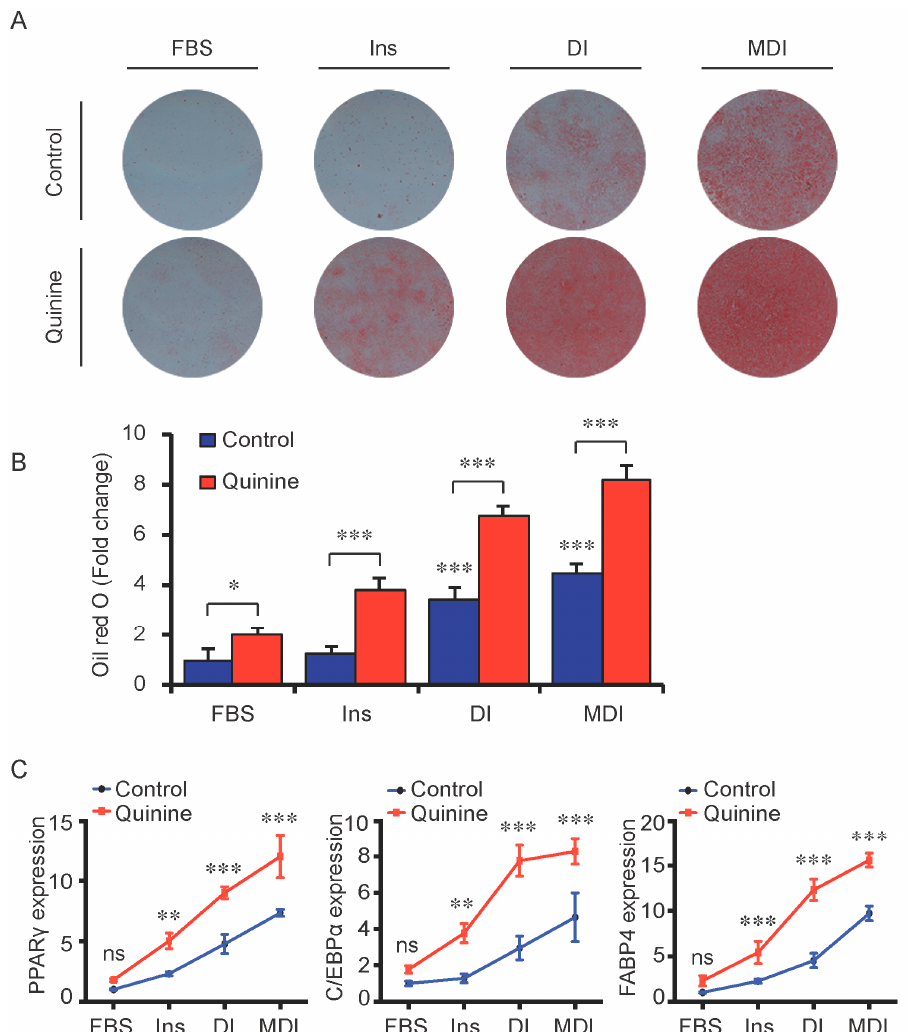
Figure 2. Quinine induced adipogenesis was independent of induction conditions. The effects of quinine on differentiation of mouse primary preadipocytes were assessed using Oil Red O stain and qRT-PCR on Day 14 of differentiation with different induction conditions (FBS alone, FBS + Insulin, FBS + DI and FBS + MDI) in the presence of 20 µM quinine. FBS alone was used as control. Ins represents Insulin. ( A ) Oil Red O stain showed lipid accumulation (pictures shown here represent three independent experiments). The plates were scanned after Oil Red O stain; ( B ) Quantification of Oil Red O stain from three independent experiments (mean ± SEM; one way ANOVA, * p < 0.05, *** p < 0.001); and ( C ) Total RNA was isolated and used for detection of PPAR γ , C/EBP α and FABP4 mRNA expression levels with qRT-PCR (mean ± SEM; n = 6; two way ANOVA; ** p < 0.01, *** p < 0.001, indicated fold change compared with cells without quinine treatment under each induction condition).